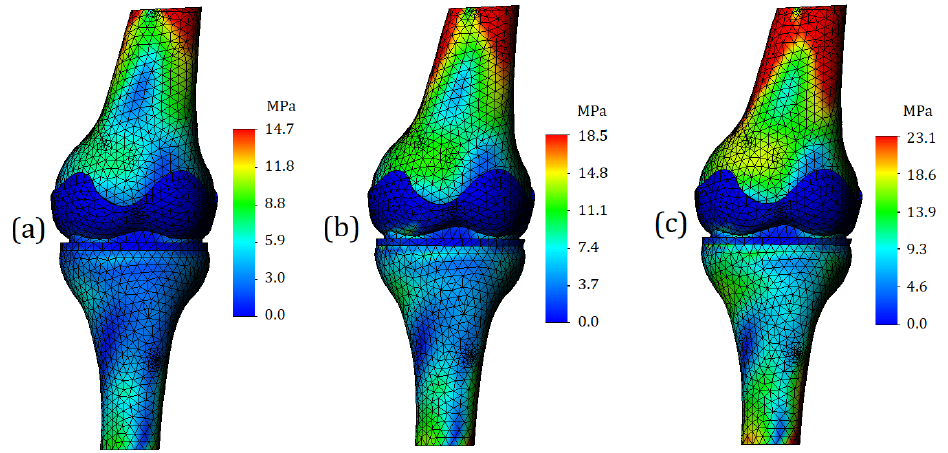
Figure 10. Von Mises stress plots in case of running. General view of the model: ( a ) With mild cartilage sti ff ness; ( b ) With moderate cartilage sti ff ness; ( c ) With severe cartilage sti ff ness.